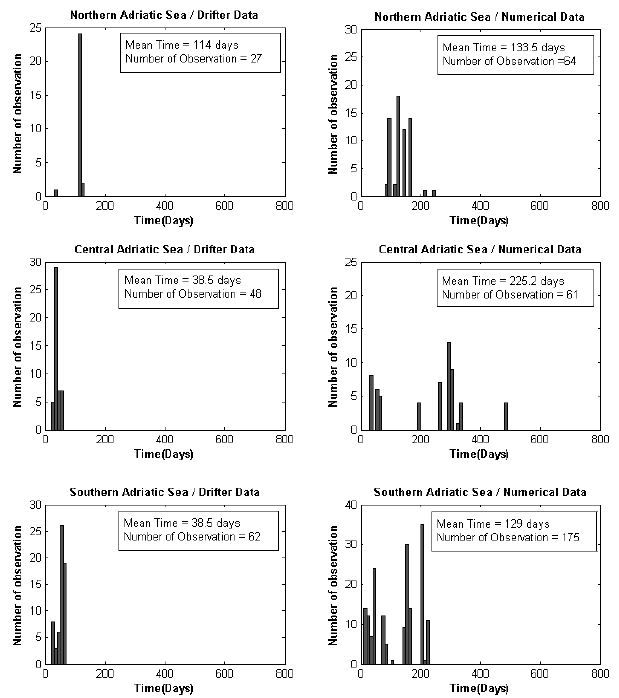
Fig. 4. Same as Fig. 2 but for the drifters entering through the east- ern section of the Otranto Channel and reaching the areas depicted with squares in Fig. 1b.